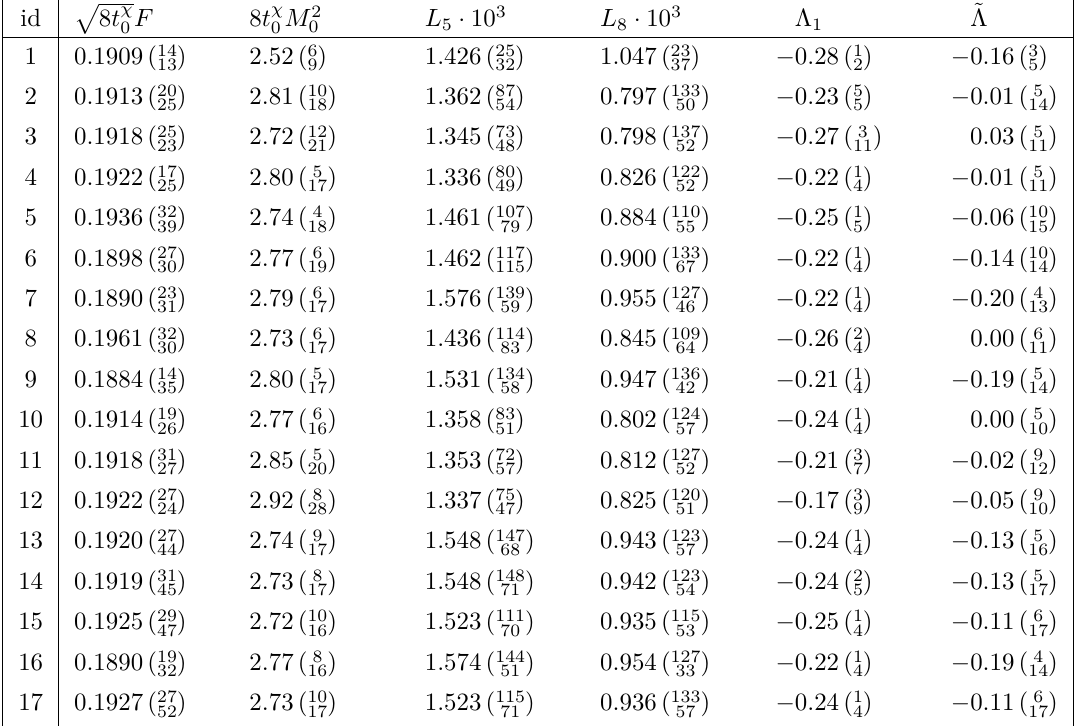
Table 8. Results for the LECs obtained when employing the fit forms detailed in table 7. The dimensionful LECs are given in units of the gradient flow scale in the chiral